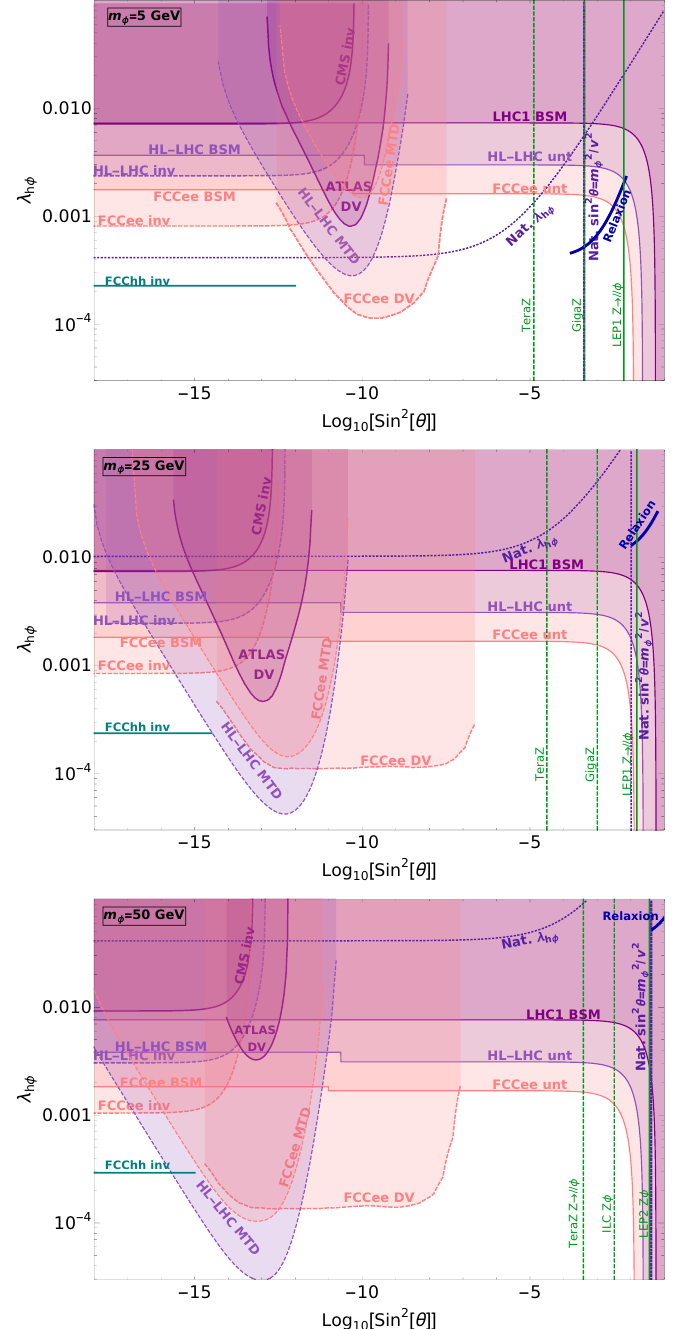
Figure 8 . Direct and indirect bounds on λ hφ and sin 2 θ for the generic scalar singlet with a mass of m = { 5 , 25 , 50 } GeV, respectively. The dotted lines represent the upper naturalness bounds φ on λ and sin θ for the singlet. The thick blue lines represent the viable relaxion parameter hφ space. In the m = 50 GeV plot, we use the result of the ATLAS search for displaced jets [60] φ for m = 55 φ